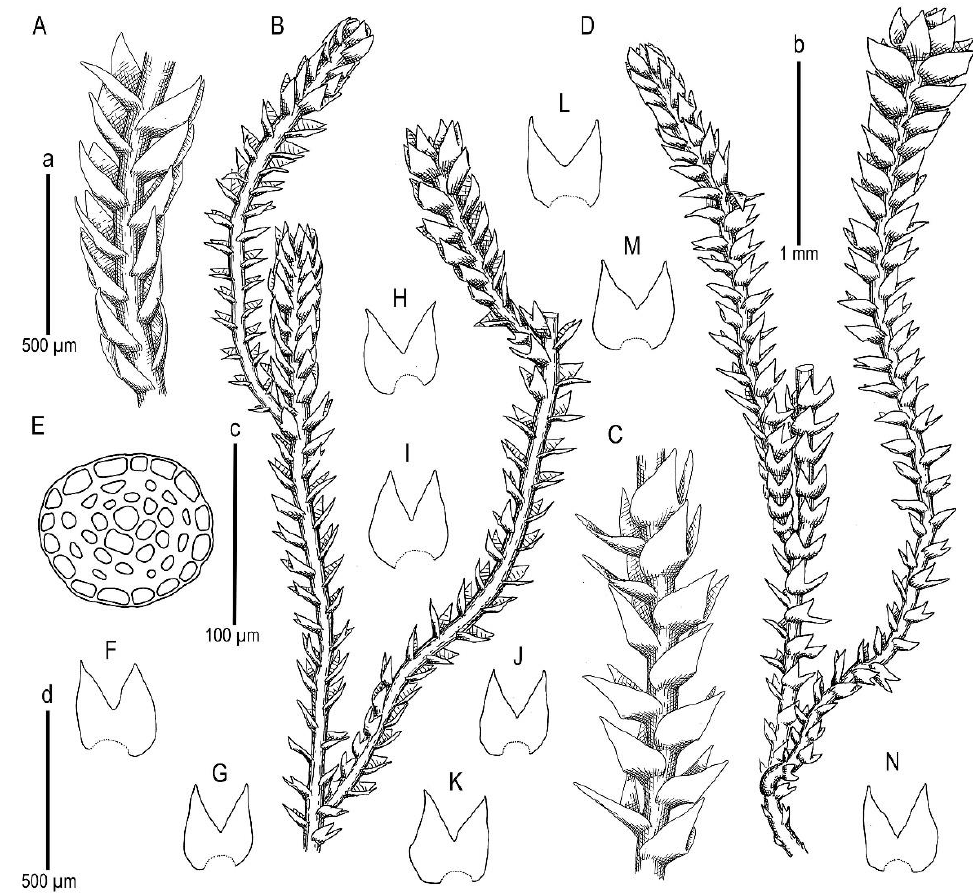
Figure 2. Marsupella anastrophylloides Bakalin, Vilnet et Maltseva sp. nov. : ( A , B ) plant habit, fragment, dorsal view; ( C , D ) plant habit, fragment, ventral view; ( E ) stem cross-section; ( F – N ) leaves. Scales: a—500 µm for ( A , C ); b—1 mm for ( B , D ); c—100 µm for ( E ); d—500 µm for ( F – N ). All from Holotype V-15-6-20 (VBGI).